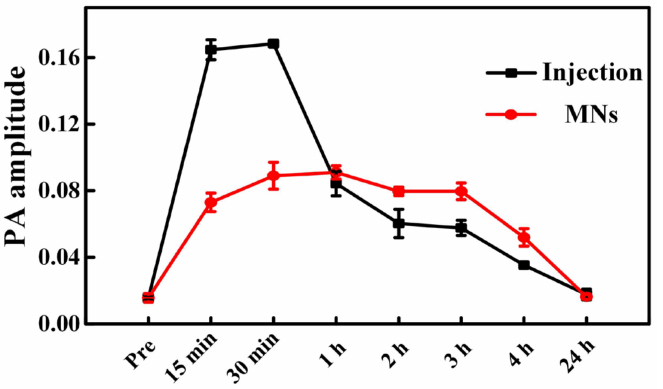
Figure 5. Comparison of the amplitude of PA signals originated from the delivered ICG after injection and transdermal administration of the